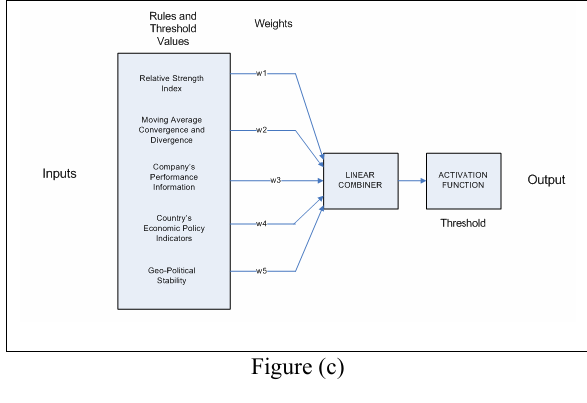
6. ALGORITHM EVALUATION AND KNOWLEDGE BASE ENHANCEMENT WITH TEST DATA